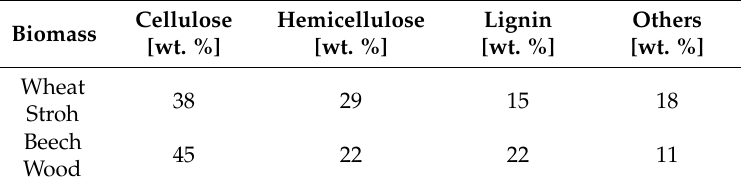
Table 2. Composition of the lignocelluloses (data from [31]).